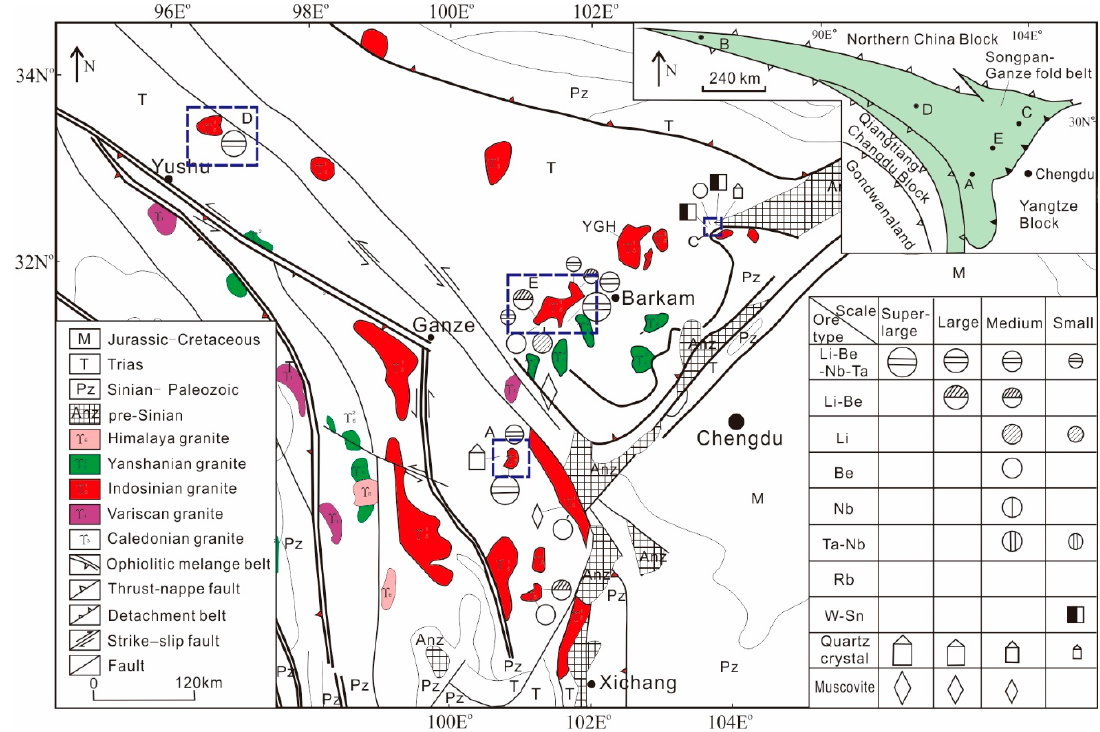
Figure 1. Distribution map of granitic pegmatite deposits in the western Sichuan Province, China. A: